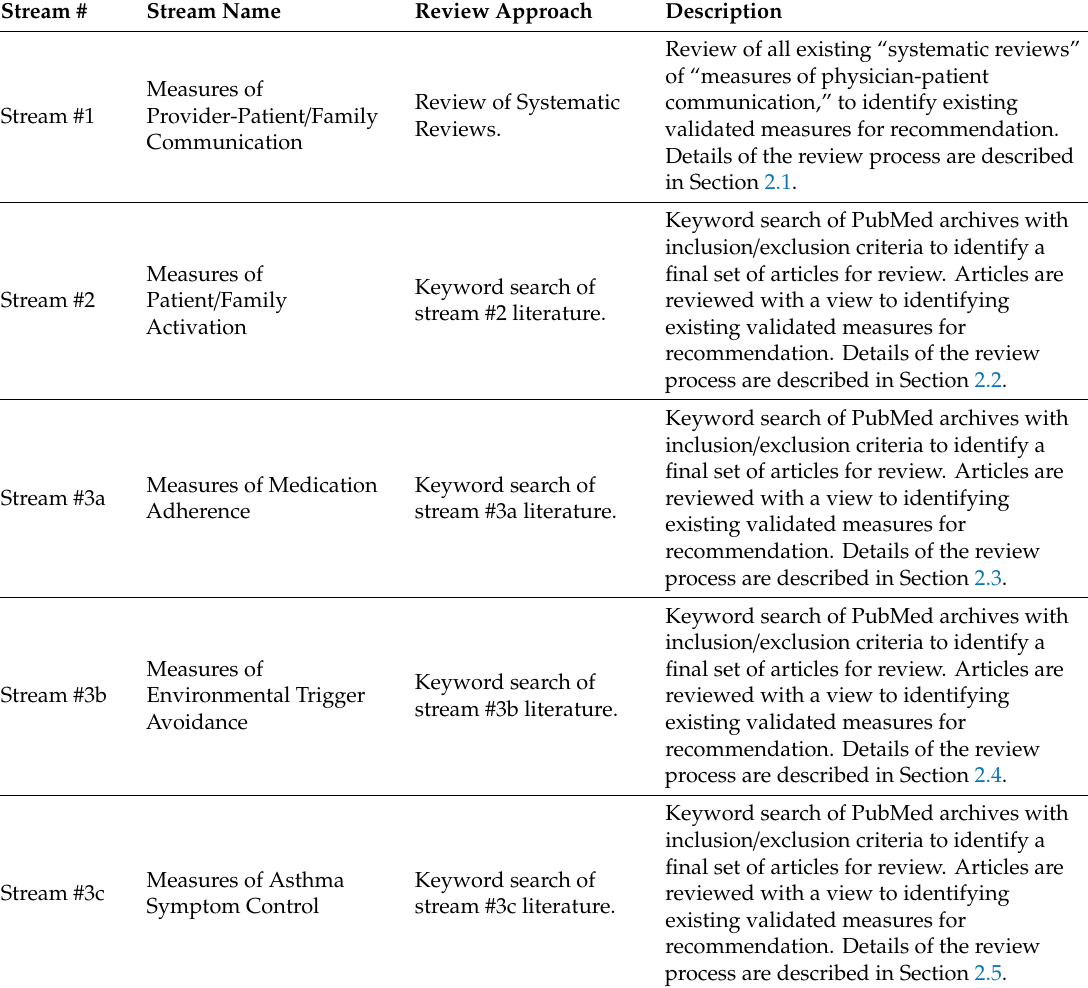
Table 1. Summary of Approaches Used for Integrative